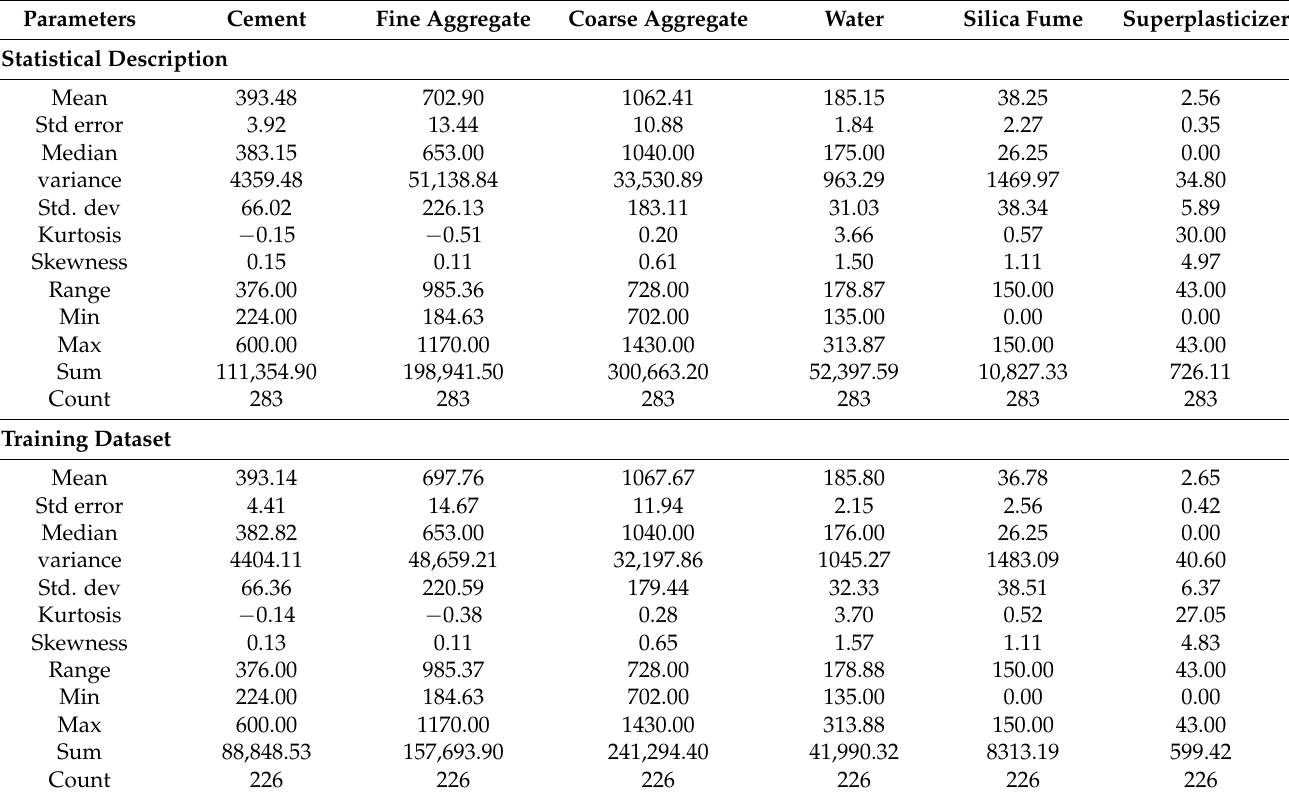
Table 2. Statistical description of data in the model for compressive strength (Kg/m 3